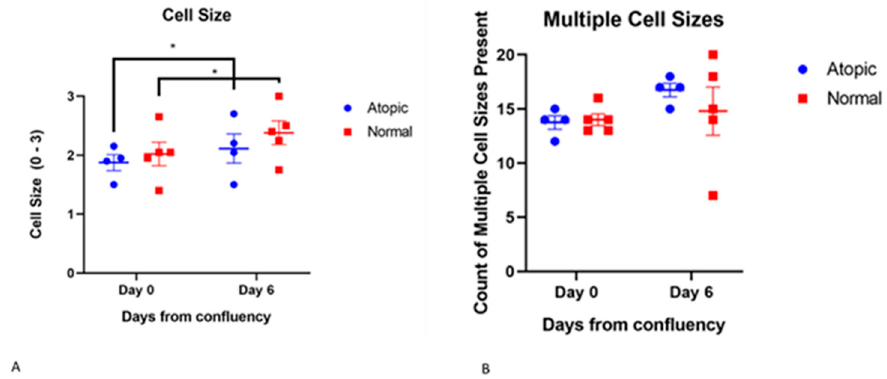
Figure 7. Size significantly increased from D0 to D6 in both groups (effect of time, p = 0.0076) but there were no differences between groups ( A , B ). No differences were found in terms of frequency of multiple cell sizes between normal and atopics. For this scoring, four atopic cell cultures and five normal cell cultures were used. * indicates p values that are p < 0.05.